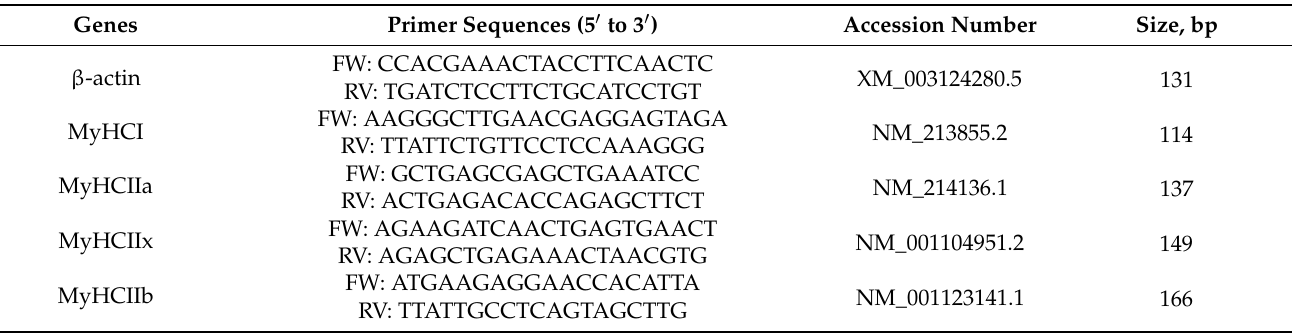
Table 3. Primer sequences for quantitative